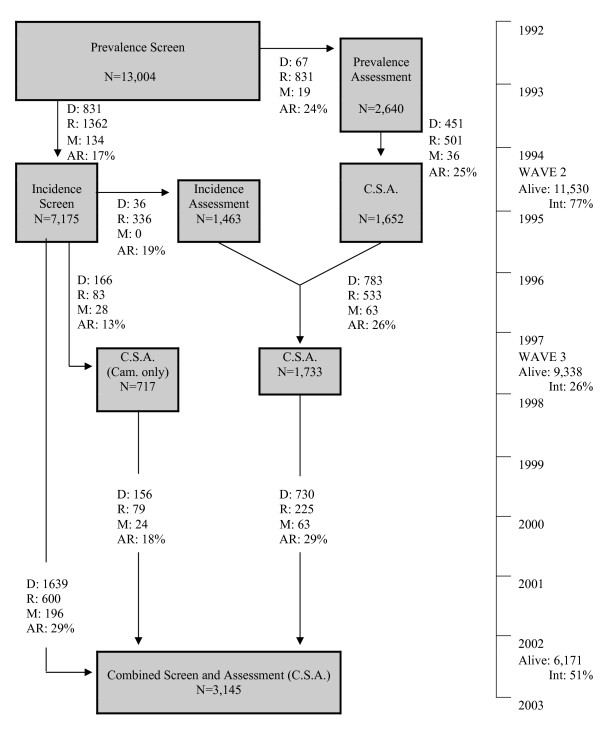
MRC CFAS design over ten years with loss to follow-up information. Key: N number interviewed; D – died between interviews; R – refused to be interviewed; M – moved between interviews; AR – attrition rate i.e. (R + M)/(R + M + N); C.S.A. – Combined Screen and Assessment; Alive – Number of baseline participants alive at median time of wave interviews; Int – Percentage of those interviewed out of those alive. Notes: Data version 8.0. Numbers may be inconsistent between waves due to temporary refusers. Position of boxes corresponds to the interquartile range of the date of the interviews.